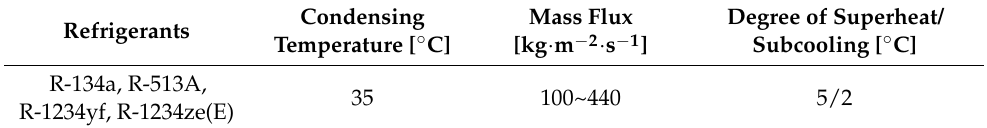
Table 2. The test